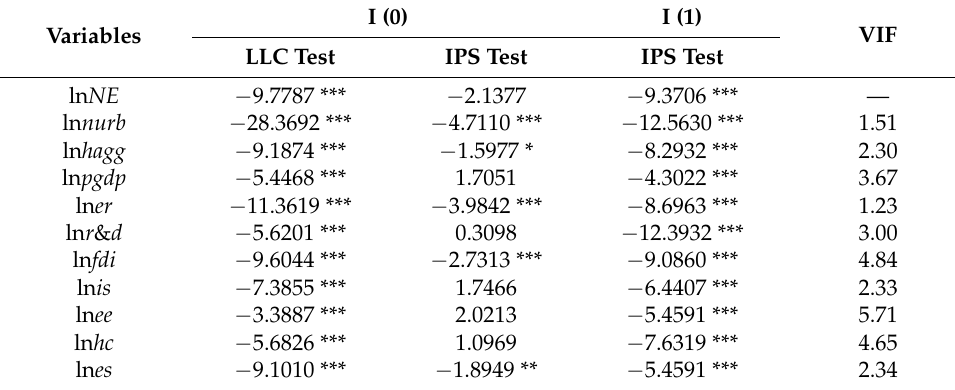
Table 3. Unit roots and multicollinearity